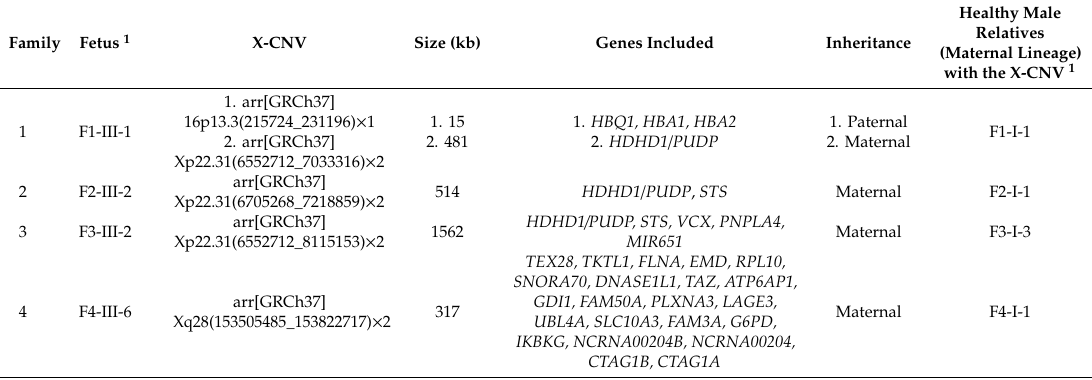
Table 1. Summary of the copy number variations at the chromosome X (X-CNVs) prenatally detected in male fetuses of four families (Family